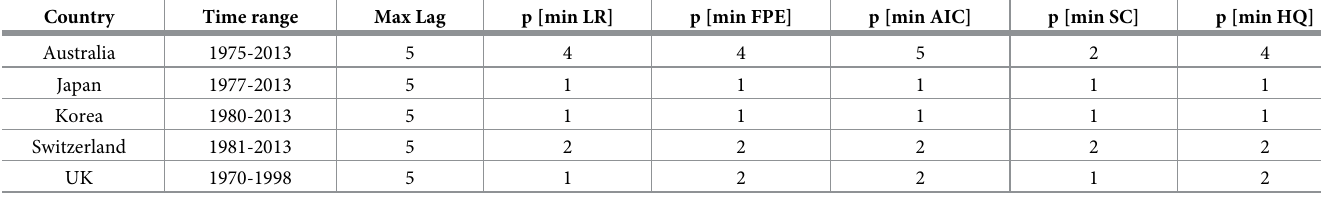
is not found to be significant at 5% level. Results are found to be stable as can be seen from the output of CUSUM test as depicted in Figs 15, 16 and 17. Table 22 depicts the ARDL Bounds Testing result for Japanese data under proposed frame- work. It can be seen from Table 22 that F-statistics of Bounds Test are found to be 3.346849, Table 6. Lag length selection (proposed